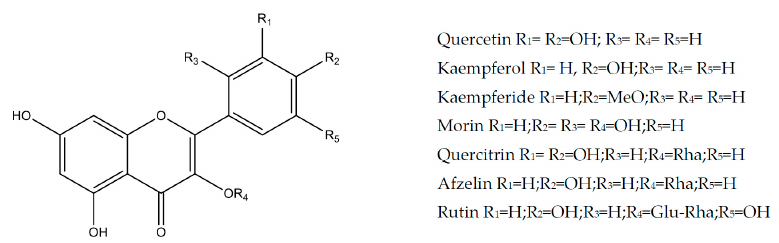
Figure 2. Flavonols with gastroprotective and/or anti-ulcer activity.